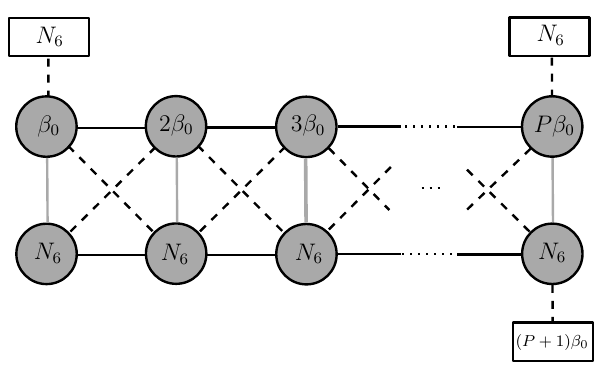
Figure 6 . 2d (0,4) quiver CFT with gauge groups of linearly increasing